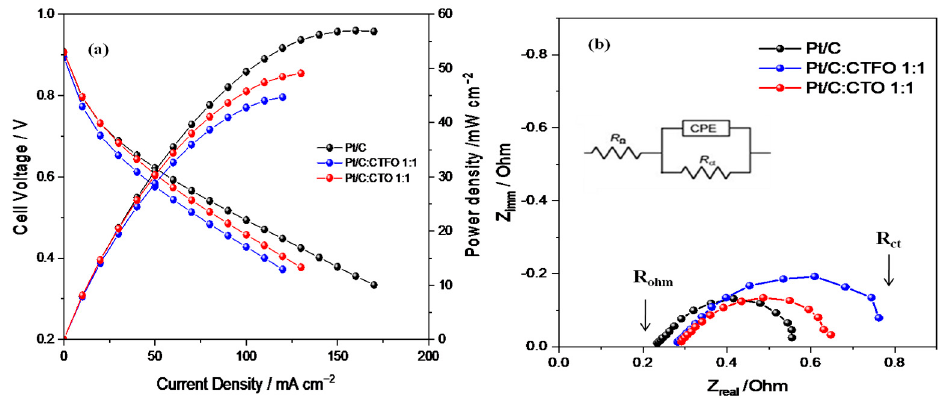
Figure 8. ( a ) Fuel cell performances and ( b ) impedance spectra recorded at 0.6 V in the frequency range of 10 kHz–1 Hz, under 30% RH and at 80 °C.